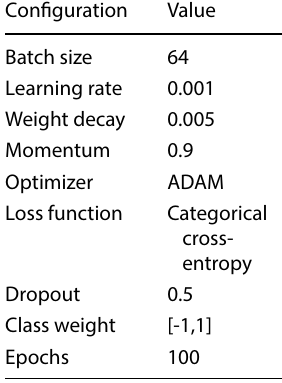
Table 2 Hyperparameters configurations to use Transfer Learning-based